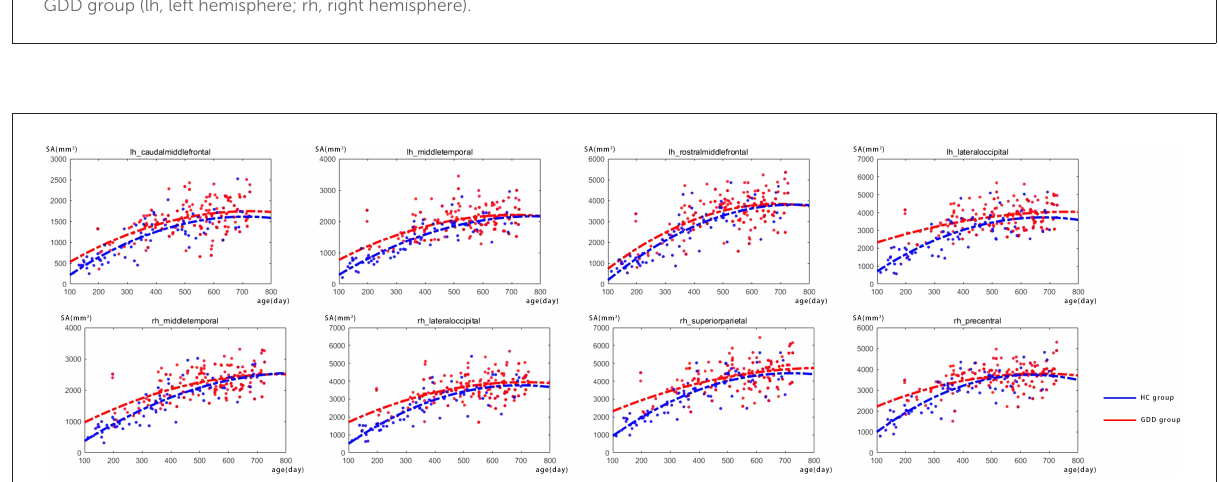
FIGURE4 There are the SA developmental trajectories of some representative regions of the two groups. The red line represents the HC group, and the blue line represents the GDD group (lh, left hemisphere; rh, right hemisphere).